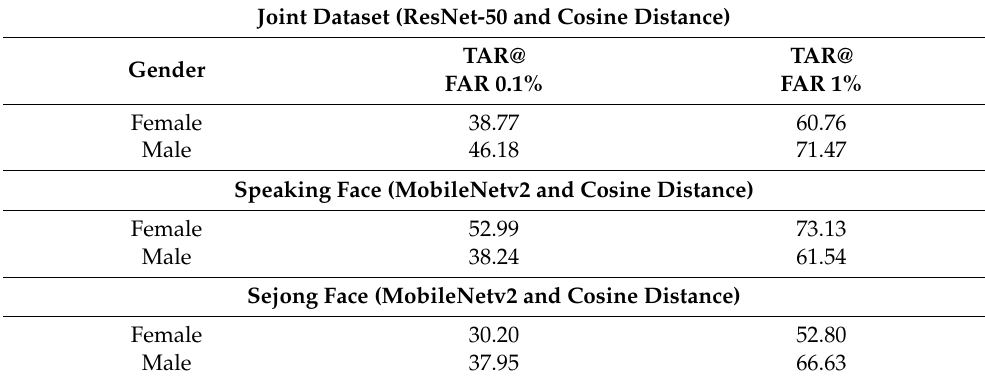
Table 9. Gender-divided performance of the triplet-based algorithm with a visible anchor image.